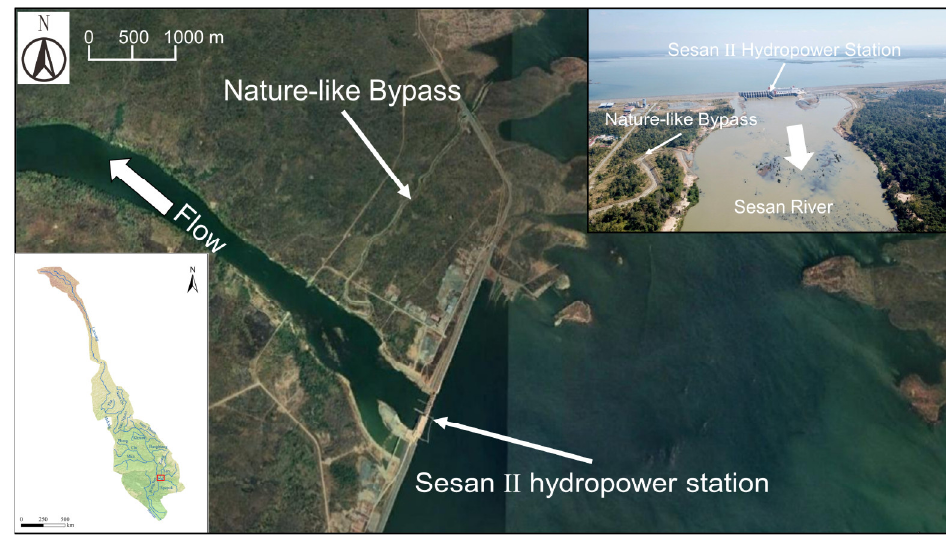
Figure 1. Location of the NLP at the Sesan Ⅱ Hydropower Station.